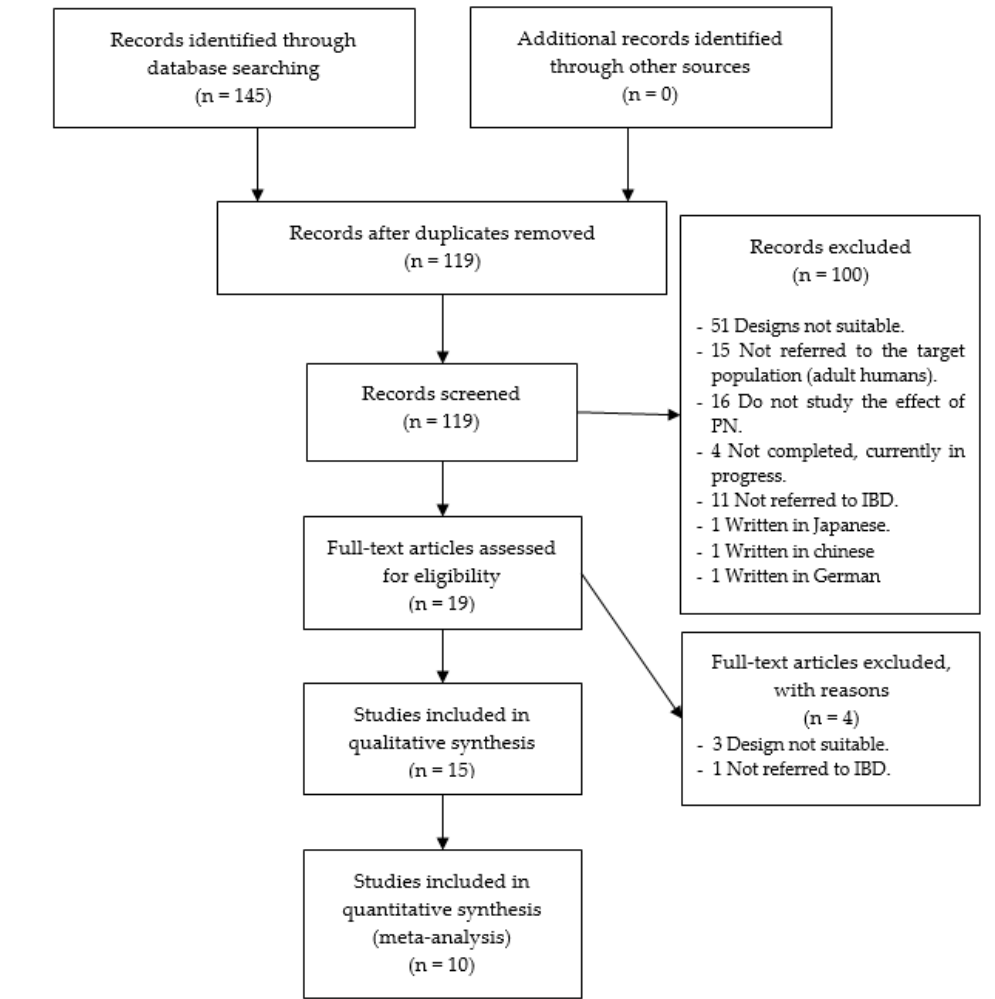
Figure 1. Identification and selection of studies/records in the databases.